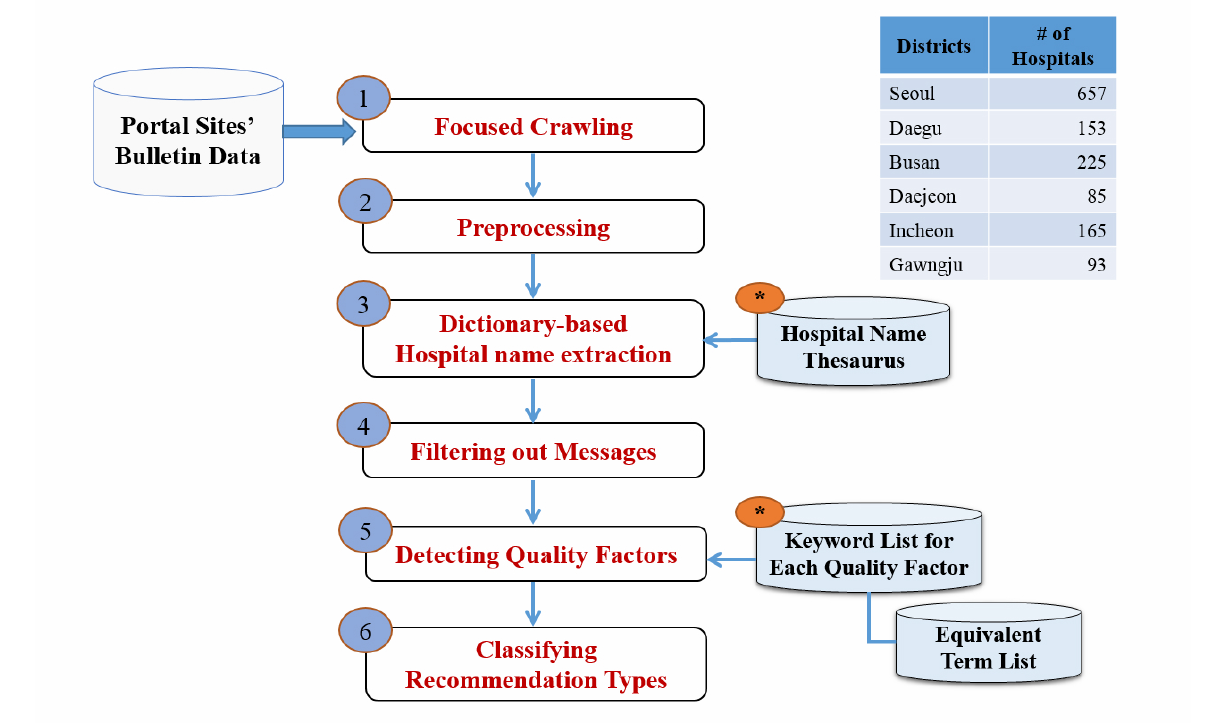
Figure 4. Steps for detecting quality factors and recommendation